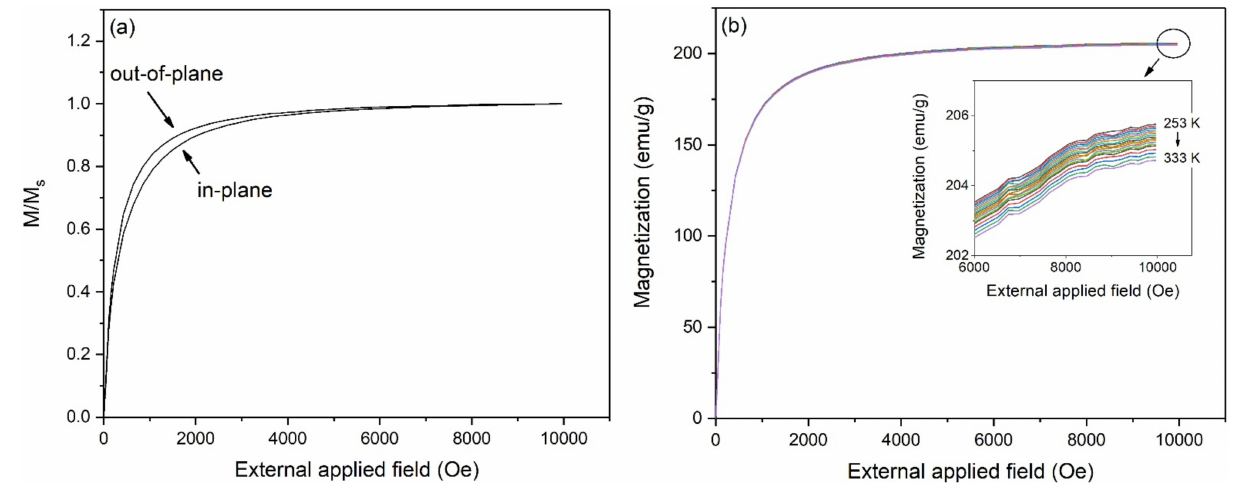
Figure 6. Isothermal magnetization curves of CoFe film at ( a ) 298 K and ( b ) 253 to 333 K. The isothermal magnetization curves under the maximum external applied field of 10 kOe of the as-sintered Ni 50 Mn 33 In 16 Cr 1 alloy and Ni 50 Mn 33 In 16 Cr 1 /Cu with 2 h-coated